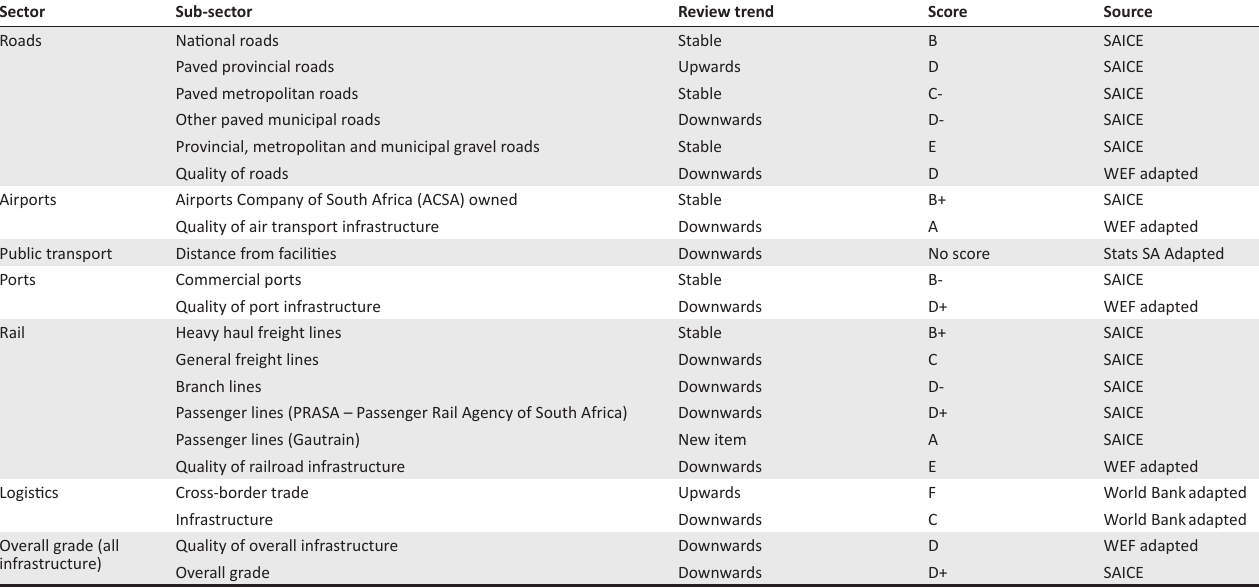
FIGURE 1: South African global competitiveness ranking on transport infrastructure. TABLE 1: South African transport infrastructure